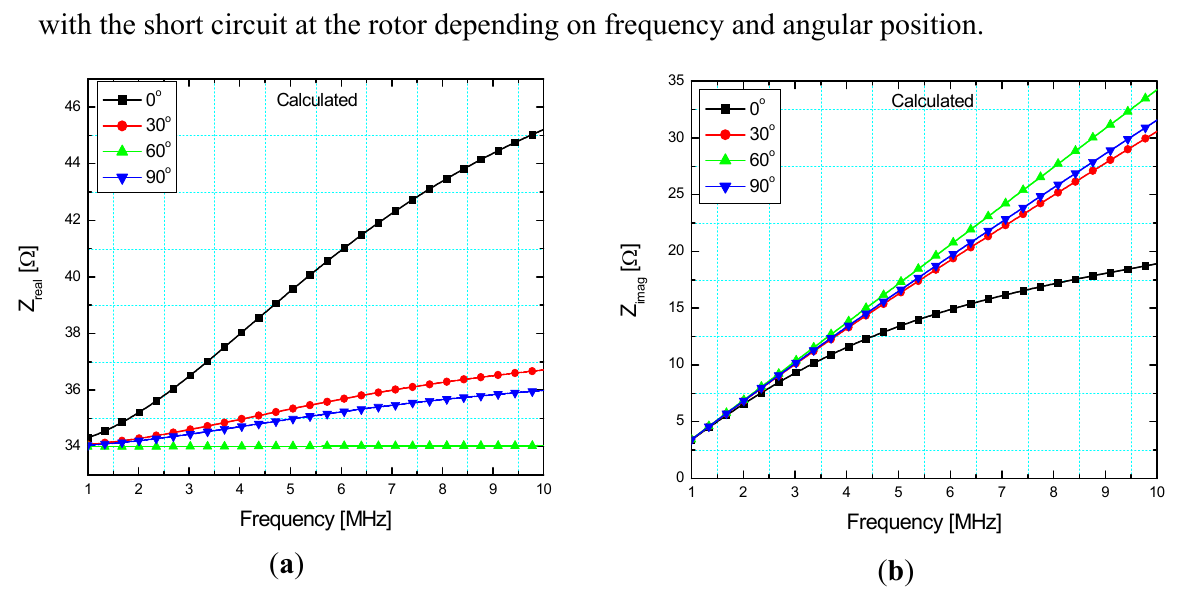
; ( b ) imaginary part– Z of the stator impedance real imag